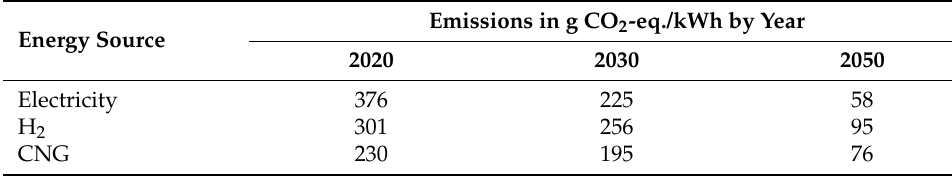
Table 8. Calculated GHG emission factors of the relevant energy sources/ fuels.